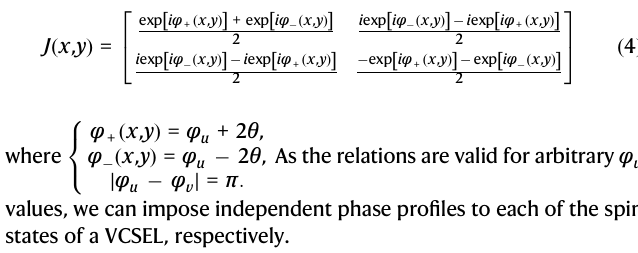
Fig.1|Conceptualdesignandintegrationprinciples.a Schematicillustrationof a spin-decoupled VCSEL via on-chip integration of a Jones matrix metasurface composed of nano fi ns, enabling imposing independent and arbitrary phase pro- fi les to the orthogonal CPs beams. In this example, spin states were encoded to displaytwodifferentholographicimagesinthefar fi eld. b Laserpeakwithsmallfull widthathalfmaximum(<0.02nm)andhighside-modesuppressionratio(>40dB) were observed from the emissionspectrum of the bare VCSEL underacontinuous